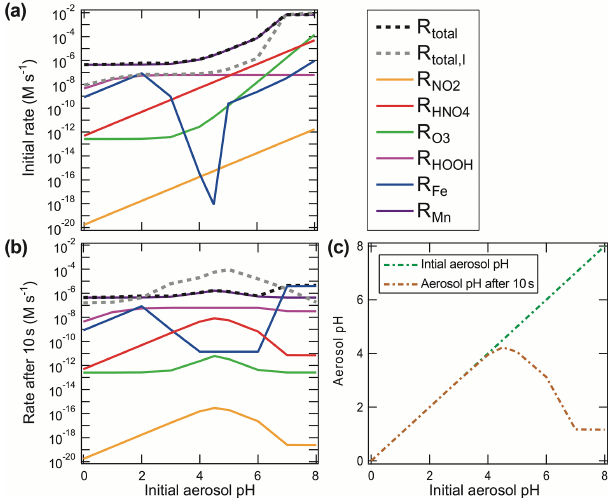
Figure 6. S(IV) oxidation rates for Beijing winter haze conditions (following Cheng et al., 2016). Shown are (a) initial S(IV) oxidation rates, (b) S(IV) oxidation rates after 10s of reaction, and (c) aerosol pH after 0 and 10s of reaction as a function of the initial aerosol pH. In the upper right legend, the S(IV) oxidation rates of the dif- ferent oxidants (NO 2 , HNO 4 , O 3 , H 2 O 2 , Fe, and Mn) are shown in (a) . The rates in (b) are listed together, with total S(IV) to S(VI) rates shown, both with and without taking the ionic strength at the maximum reported limit into account. Rates used were those rec- ommended in this